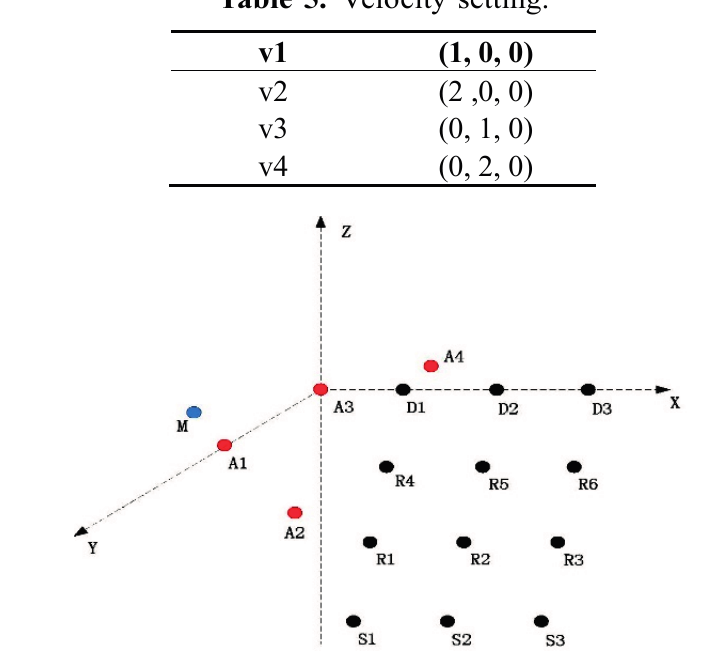
Figure 11. Network topology.